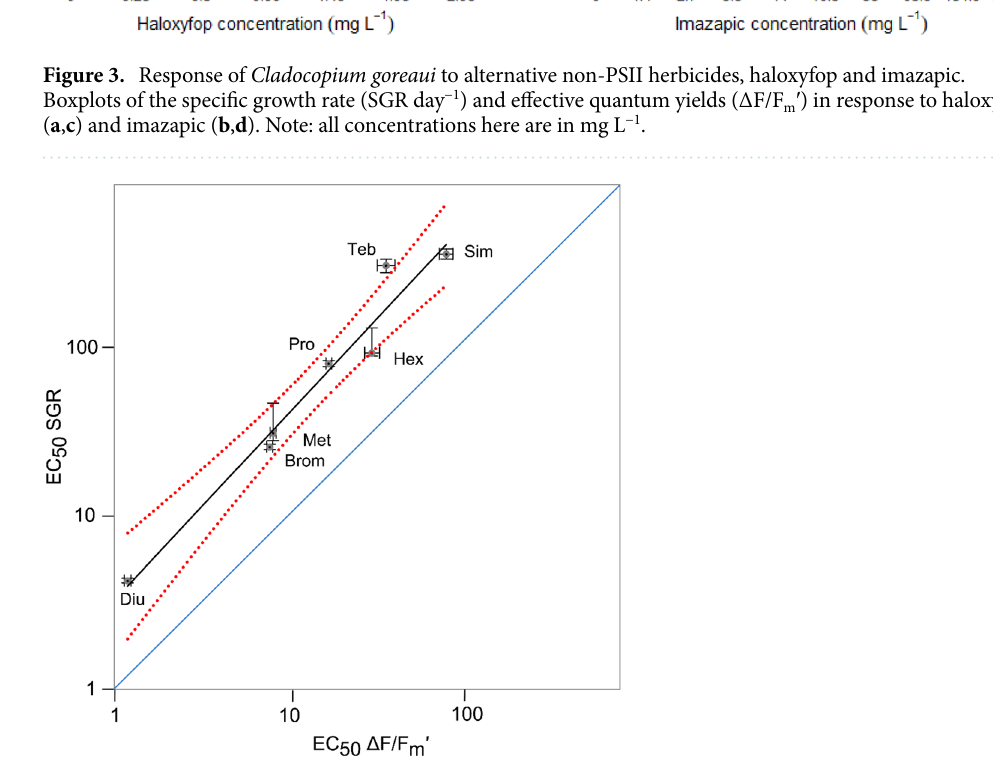
Figure 4. Linear relationship (black line) between inhibition of effective quantum yield (ΔF/F m ′ ) and inhibition of specific growth rate (SGR) in Cladocopium goreaui by PSII herbicides (dashed red lines 95% confidence bands). Error bars are 95% CI for each EC 50 value. Blue line indicates 1:1 relationship. Diu - diuron, Brom - bromacil, Hex - hexazinone, Met - metribuzin, Pro - propazine, Sim - simazine, Teb -